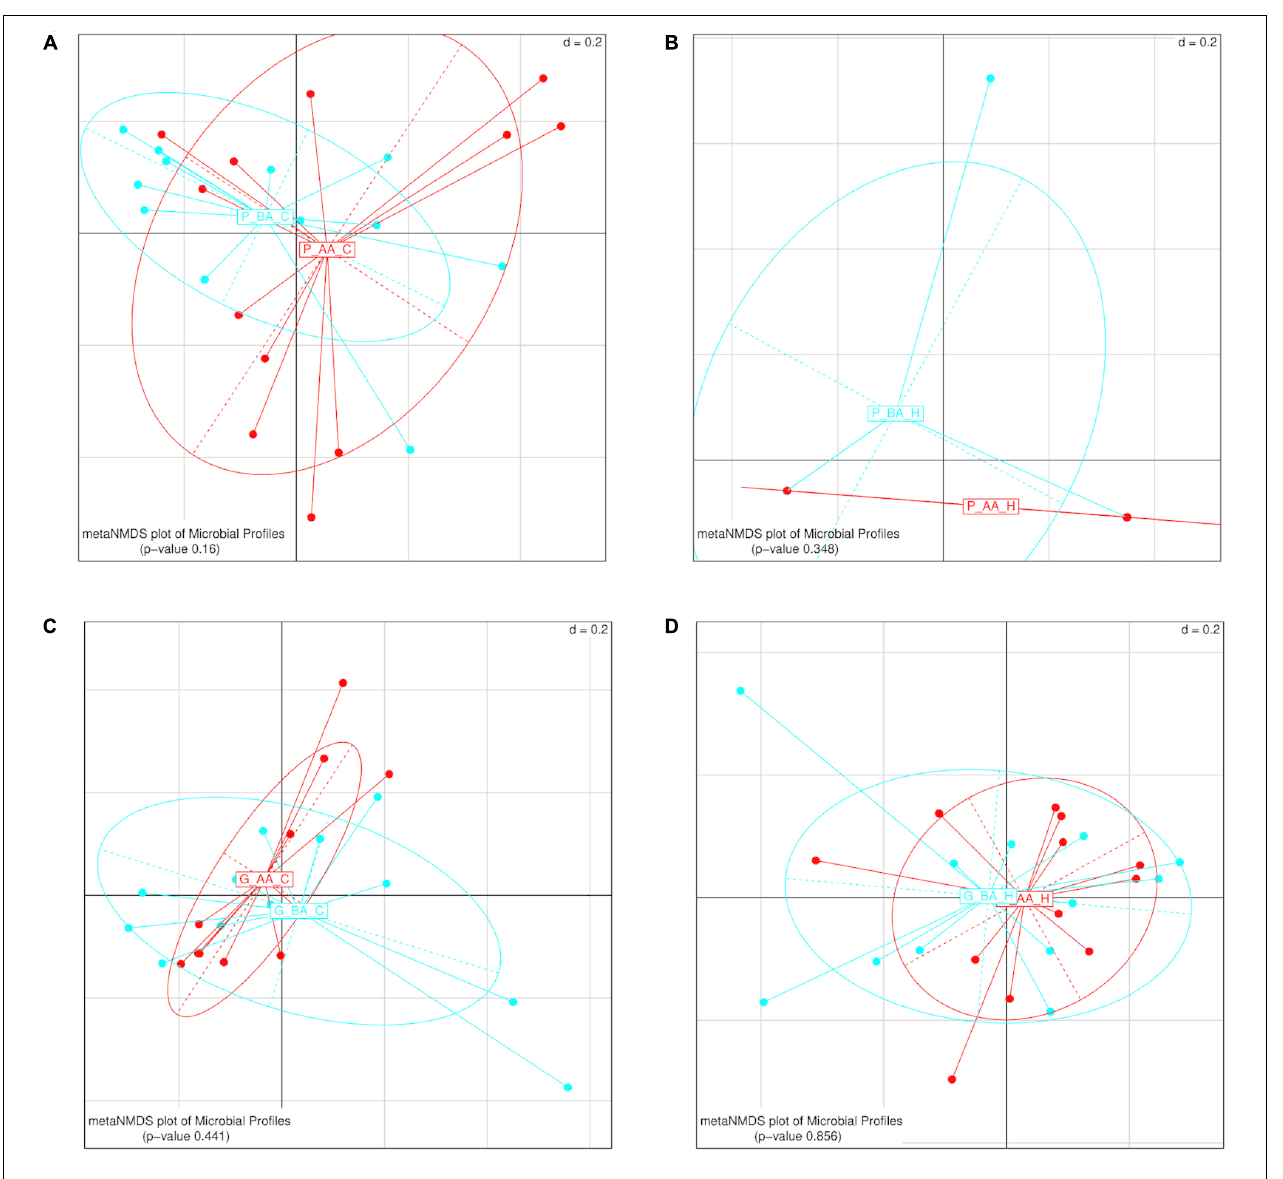
FIGURE 8 | β -diversity analyses of the gut bacterial profile of wild Anastrepha fraterculus larvae recovered from fruits of different weight, within the same host fruit species and geographic origin. The effect of weight was plotted as Meta Non-metric Multidimensional scaling (meta NMDS) graph. (A) Peaches sampled in Concordia; (B) peaches sampled in Horco Molle; (C) guavas sampled in Concordia; (D) guavas sampled in Horco Molle. The p -values correspond to PERMANOVA tests. AA, fruits whose weight was above the mean weight across all sampled fruits of the same species; AB: AA, fruits whose weight was below the mean weight across all sampled fruits of the same